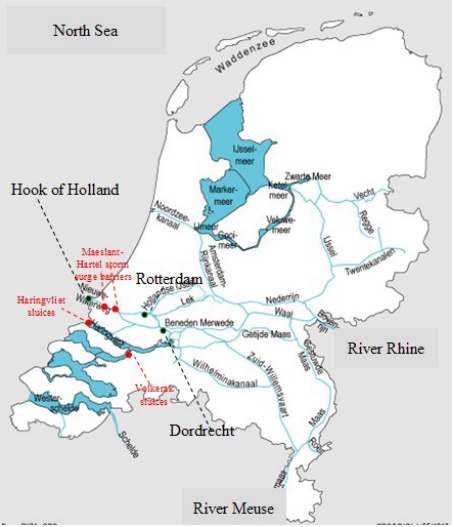
Figure 4. The Rhine Delta with operated hydraulic structures [19,20].